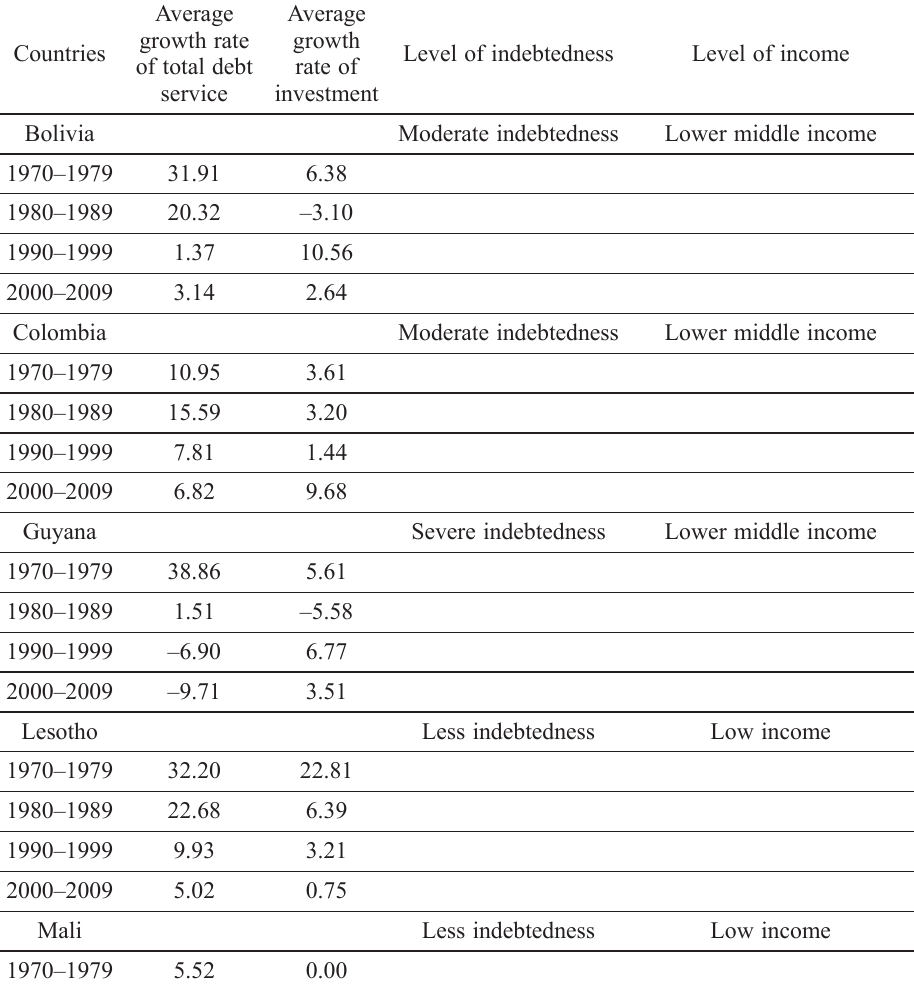
Table 6. The impact of external debt to